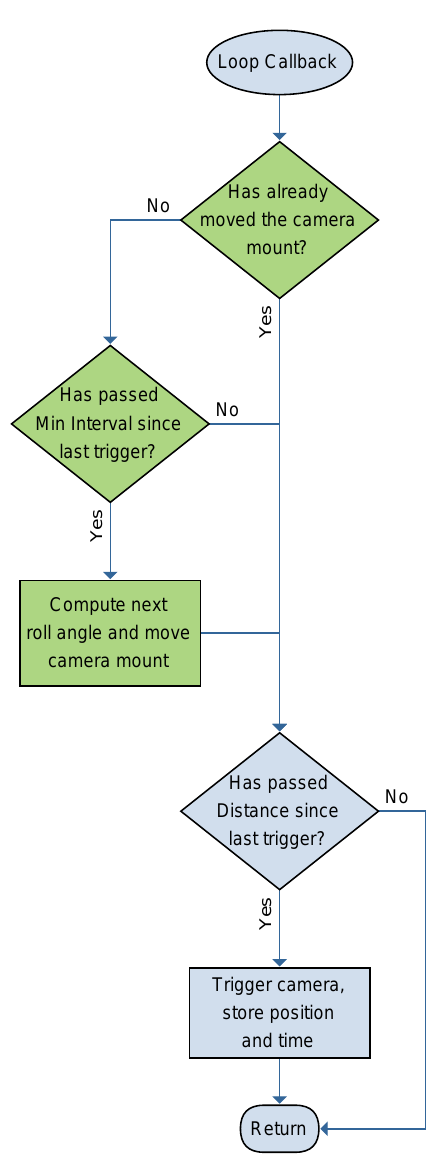
Figure 2. CAMPOS autopilot logic additions in green.